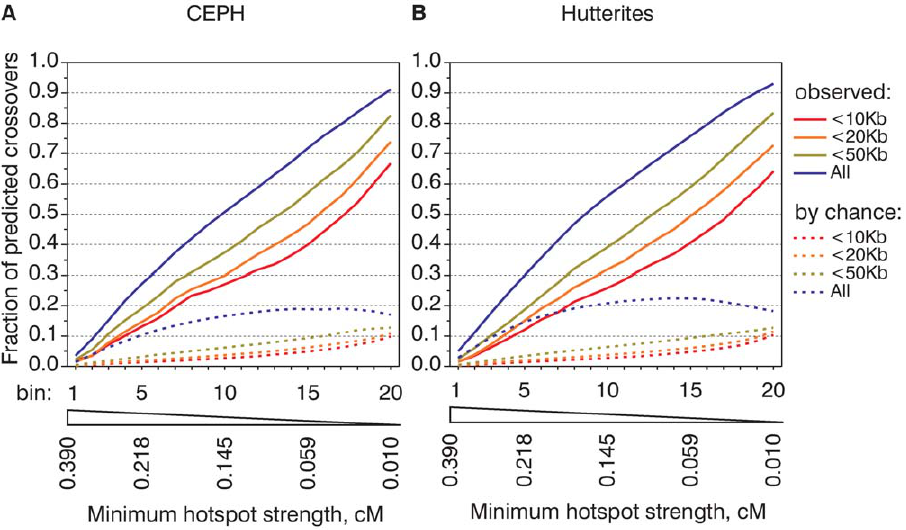
Figure 2. Hotspots of different strengths are equally active in recombination. Cumulative recombination frequency graphs of CEPH (A) and Hutterite (B) crossovers. All CEU hotspots were ranked by the strength from the strongest (bin1) to weakest (bin20) and divided into twenty bins of equal aggregate strength. For each bin we calculated fractions of CEPH (A) and Hutterite (B) crossovers predicted by hotspots from analyzed bin and bins with stronger hotspots. For the analysis all crossovers were divided in sets based on the mapping accuracy. For comparison, we calculated the fractions of crossovers that overlap hotspots by chance (see Text S1 for details on calculation) and plotted their mean values (dashed lines).